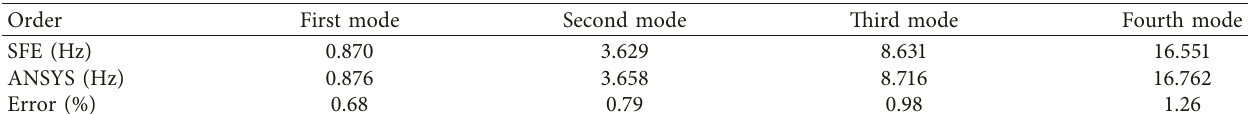
Figure 2: Spectral finite element of a tapered thin-walled rotor Table 1: Comparison of the first four flexural modal frequencies of a tapered cylinder beam.